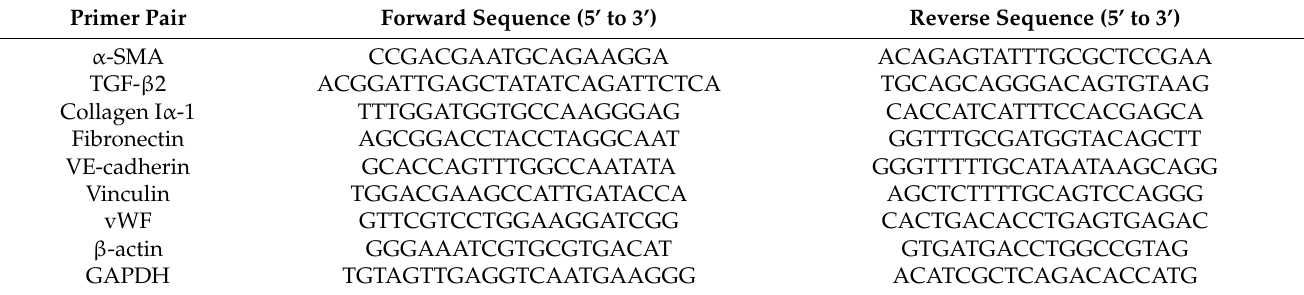
Table 3. Primer pair sequences used in quantitative real-time